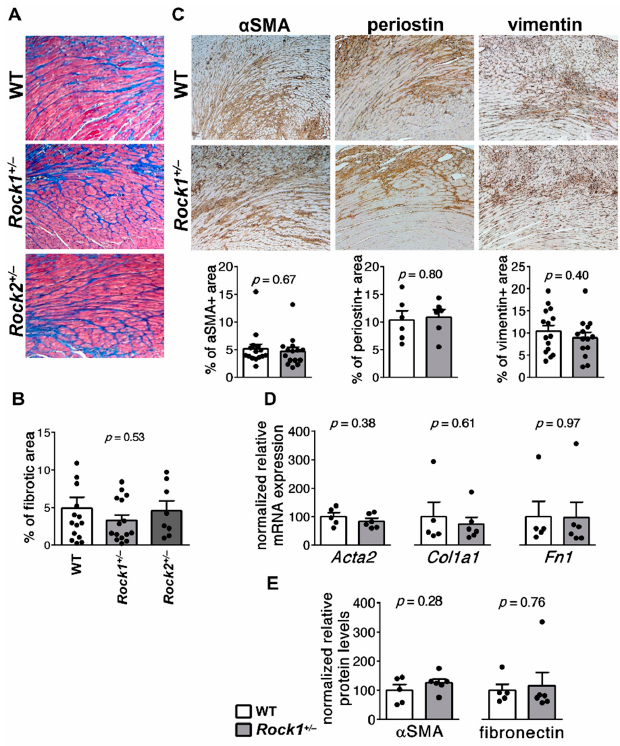
Figure 6. Rock1 +/ − and Rock2 +/ − mice are not protected from postinflammatory cardiac fibrosis. Panel ( A ) shows representative Masson’s trichrome staining (indicating fibrosis) of heart tissue sections obtained from wild-type (n = 14), Rock1 +/ − (n = 15) and Rock2 +/ − (n = 8) mice at day 40 of EAM. Magnification ×400. Quantification of fibrotic area is shown in ( B ). Representative immunohistochemistry stainings for α SMA, periostin and vimentin on heart sections of wild-type and Rock1 +/ − mice at day 40 of EAM and the respective quantifications of immunopositive areas are presented in ( C ). Panel ( D ) shows relative expression of selected profibrotic genes (n = 5) and panel ( E ) α SMA and fibronectin protein levels (n = 5) measured by immunoblotting in wild-type and Rock1 +/ − hearts at day 40 of EAM. Each dot represents data for one mouse and bars present mean value ± SEM. P -values were calculated with the ANOVA test (B) or the unpaired Student’s t -test ( C – E ).